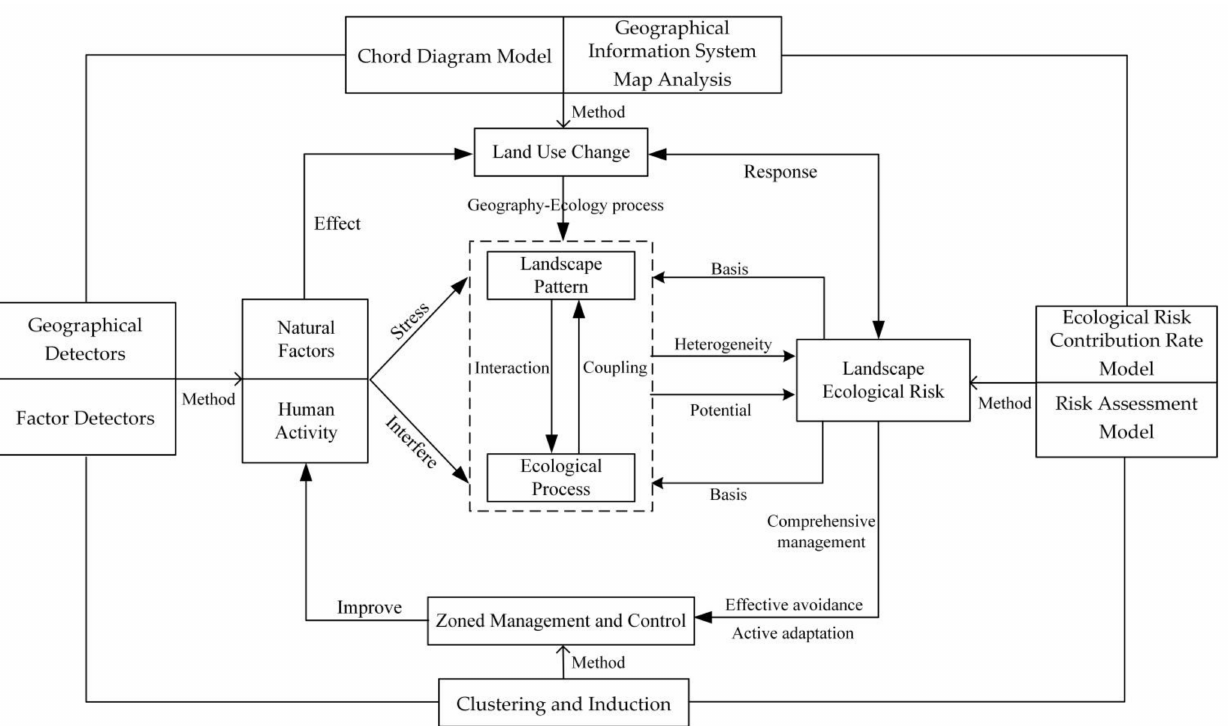
Figure 2. The framework of this